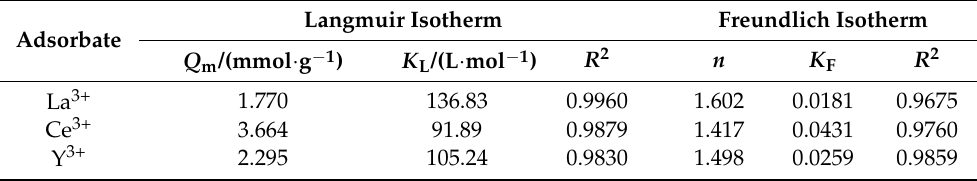
Figure 9. Linear forms of Langmuir isotherm and Freundlich isotherm. Table 7. Langmuir and Freundlich adsorption isotherm